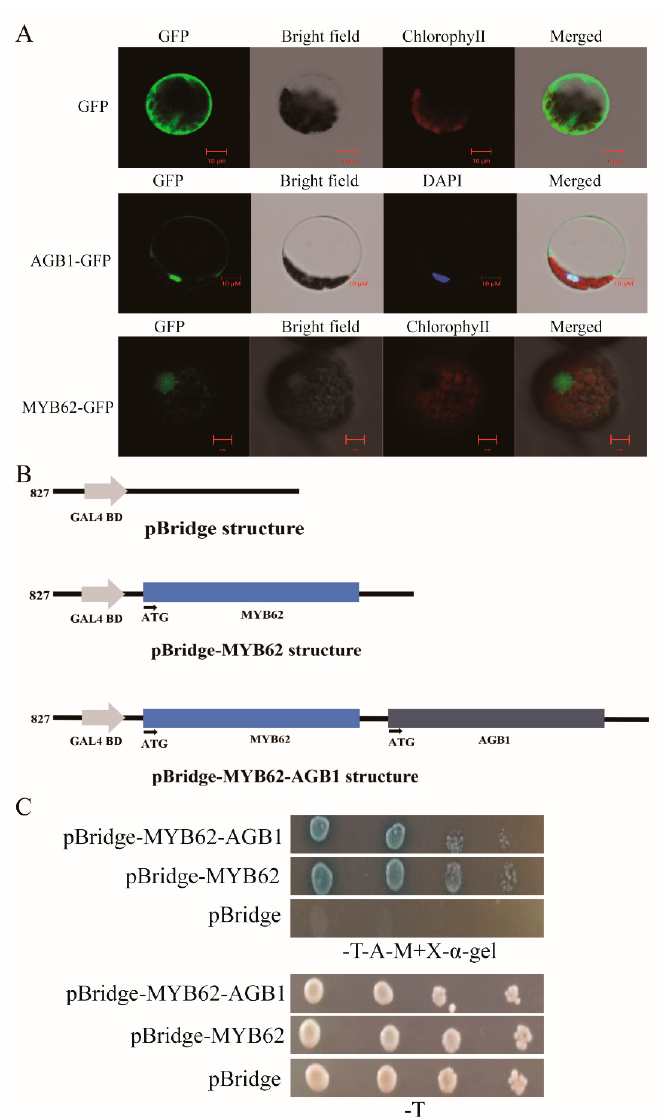
vector 16318-MYB62-GFP (Figure 5A), consistent with a previous report on the localization of MYB62 in plant cells [32] (Devaiah, Madhuvanthi, Karthikeyan, & Raghothama, 2009). These results indicated that AGB1 and MYB62 are co-located in the nucleus.